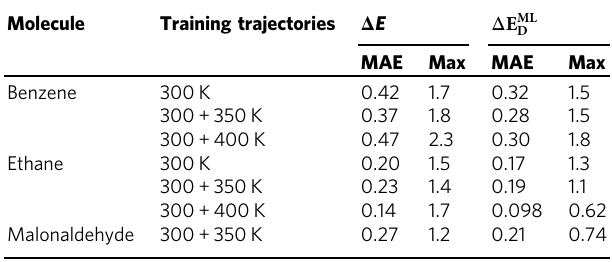
Table 3 Energy and density-driven errors of the ML-HK approach on the MD data